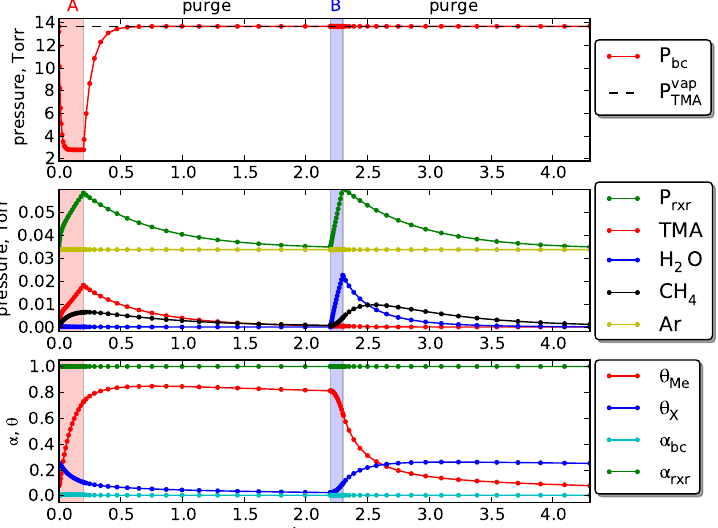
Figure 6. Representative reactor limit-cycle solution with gpc = 0 . 806 ˚ A/cycle. Reactor nominal conditions consist of τ V /V = 0 . 02% bc rxr